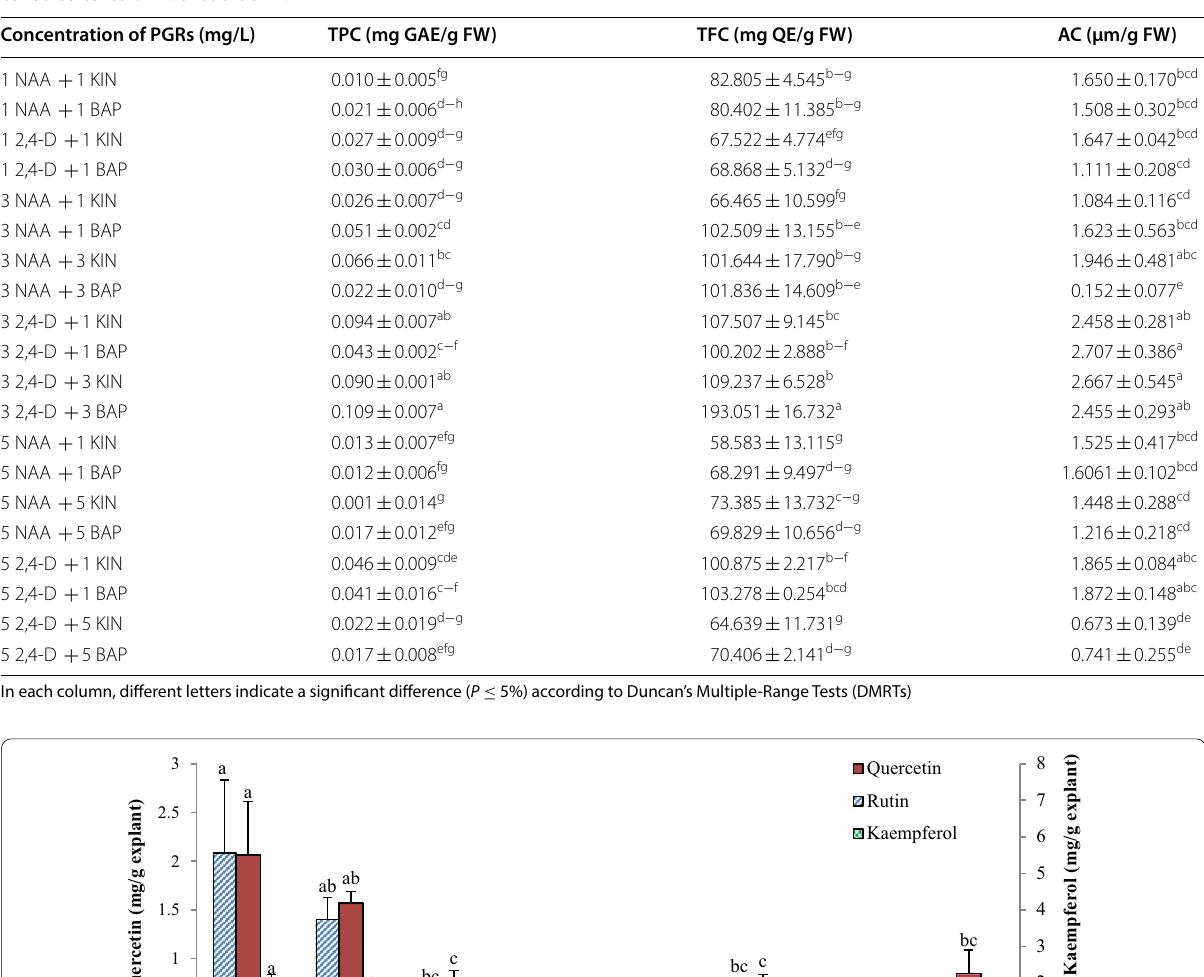
5%) according to Duncan’s Multiple-Range Tests ≤